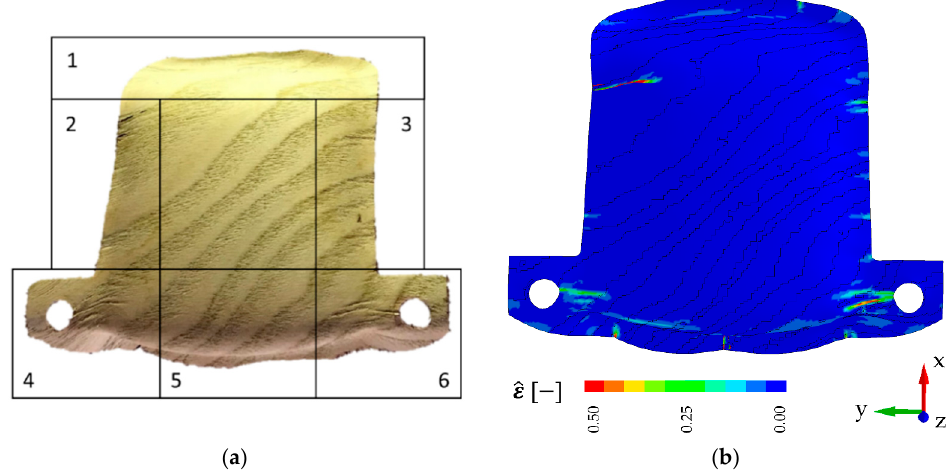
Figure 11. Forming results of sample 𝟑 ∥ . ( a ) Experiment; ( b ) simulation with output of equivalent strain.